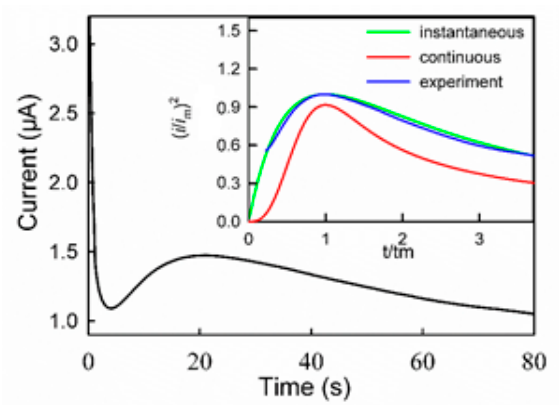
Figure 1. Current versus time transient during the potentiostatic electropolymerization of geminal dicationic ionic liquid (GDIL)–TiO 2 at a potential of 1.1 V. Inset: comparison of the experiment curve with theoretical curves from the Scharifker–Hills model.